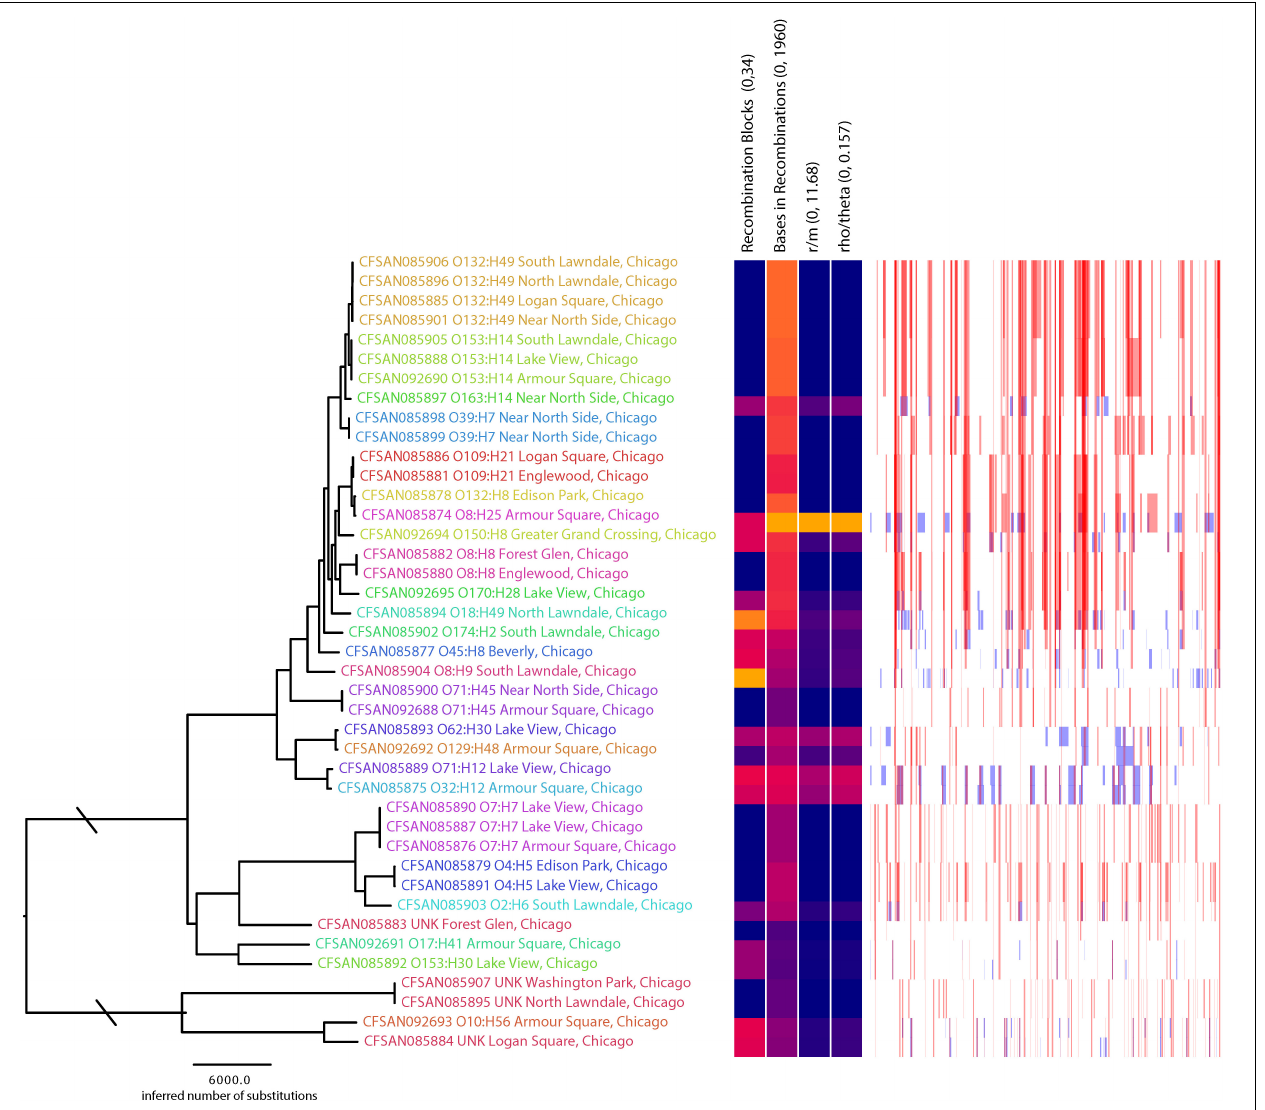
FIGURE 2 | Phylogenetic tree inferred using FastTree with the matrix with recombination filtered based on the analysis with Gubbins. Column labels on the heatmap include the range of values where blue represent 0 and red represents the maximum value. Plot next to the heatmap shows the locations among the phylogeny where there is evidence of recombination; red lines indicate recombination was evidence among terminal branches where blue indicates recombination occurring among internal branches of the phylogeny. Phylogenetic tree tip labels are colored according to serotype; labels also include the